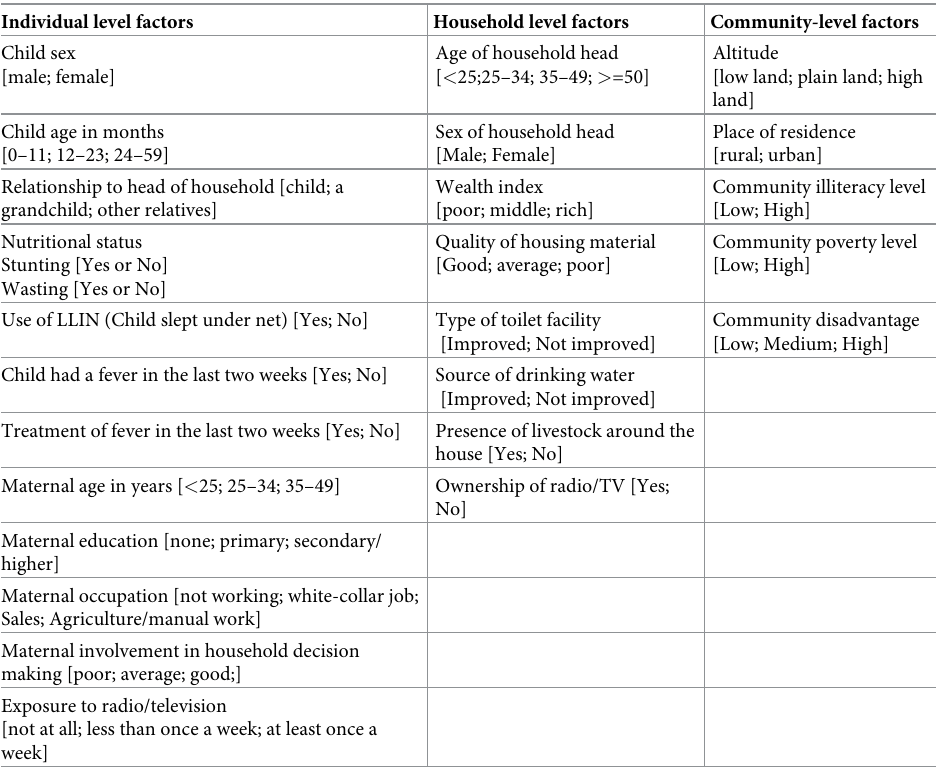
Table 1. List of explanatory